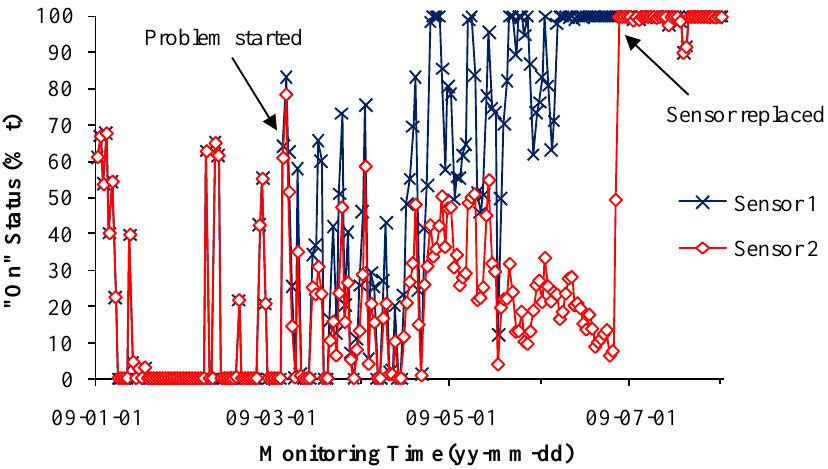
Figure 7. Normal signals from Sensor 1 compared with unsteady sensitivity signals from Sensor 2 using daily mean data from January 1 to August 1,